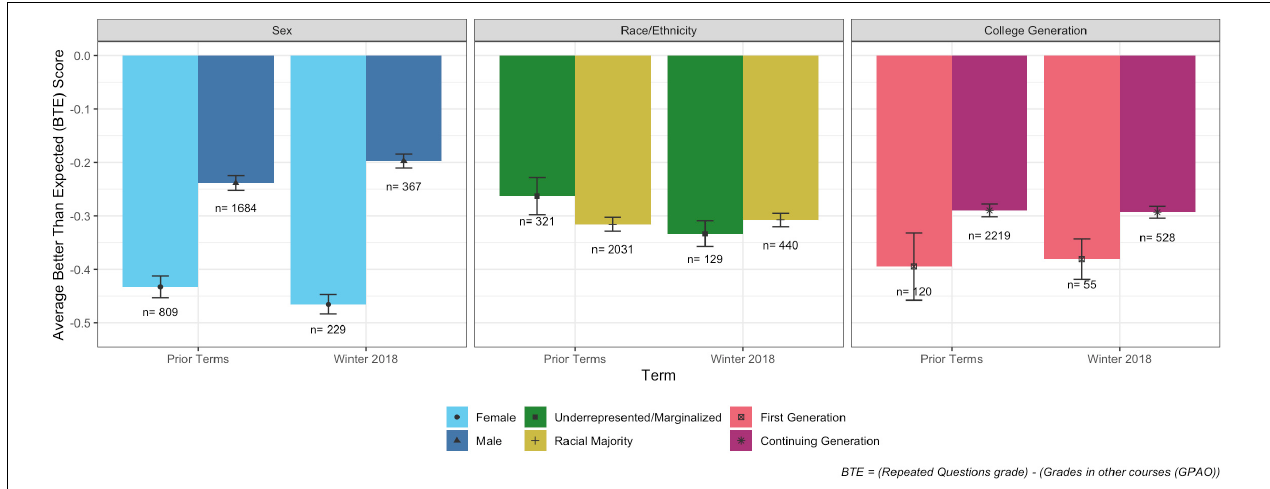
FIGURE 2 | Performance differences in BTE scores for different demographic group comparisons. Prior Terms had standard exam time; Winter 2018 term had extended exam time.